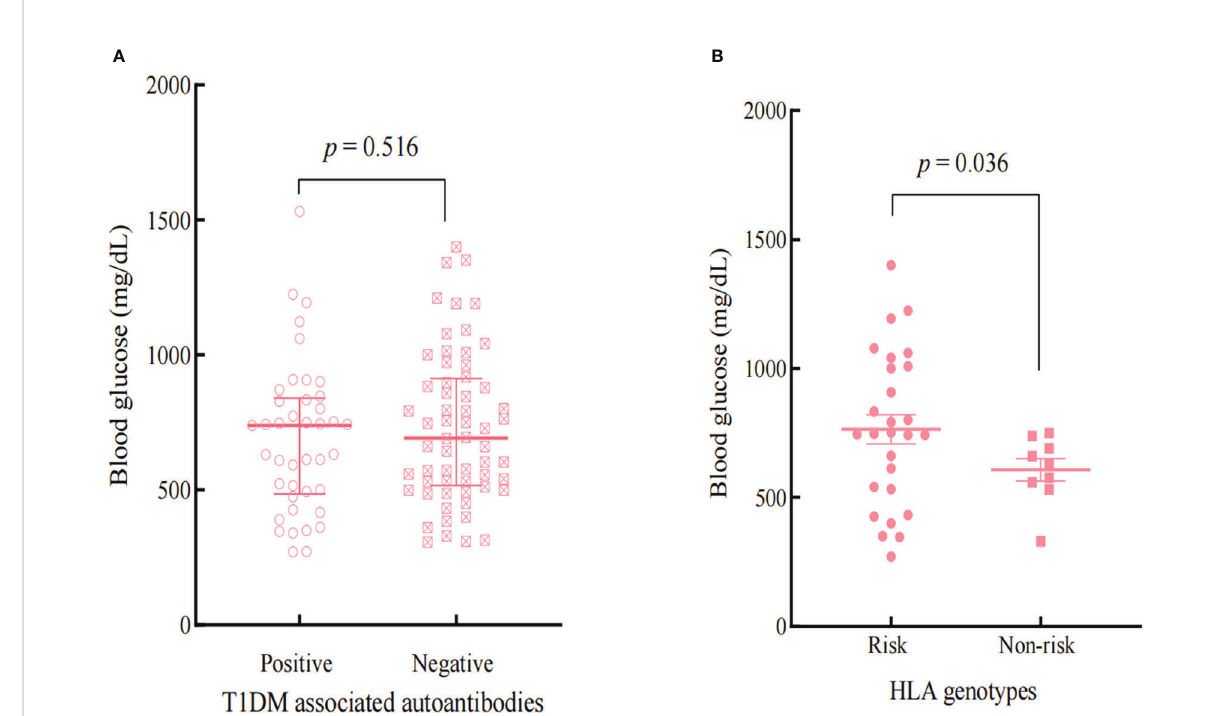
FIGURE 3 Comparison the effects of T1DM-associated autoantibodies (A) and HLA genotypes (B) on the BG at the onset of